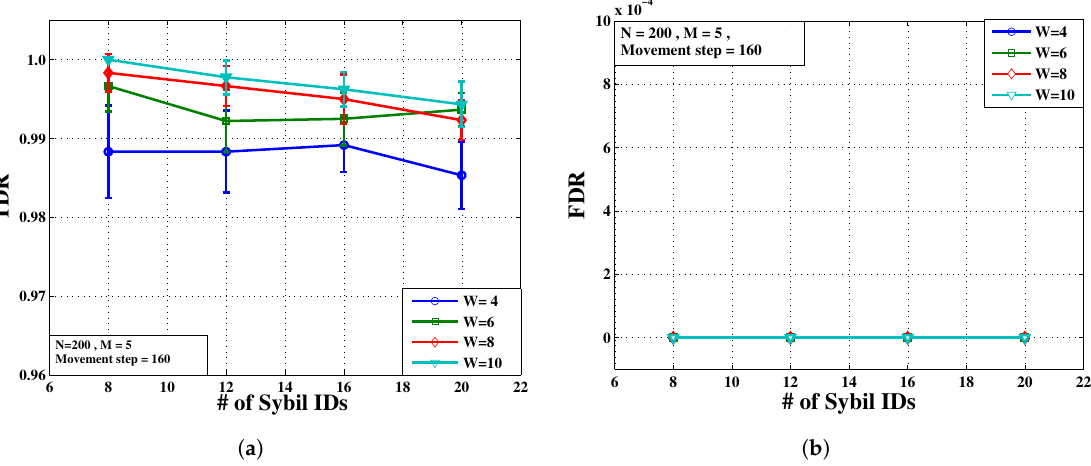
Figure 10. The effect of WD population on the variation of TDR ( a ) and FDR ( b ) versus the number of Sybil IDs.